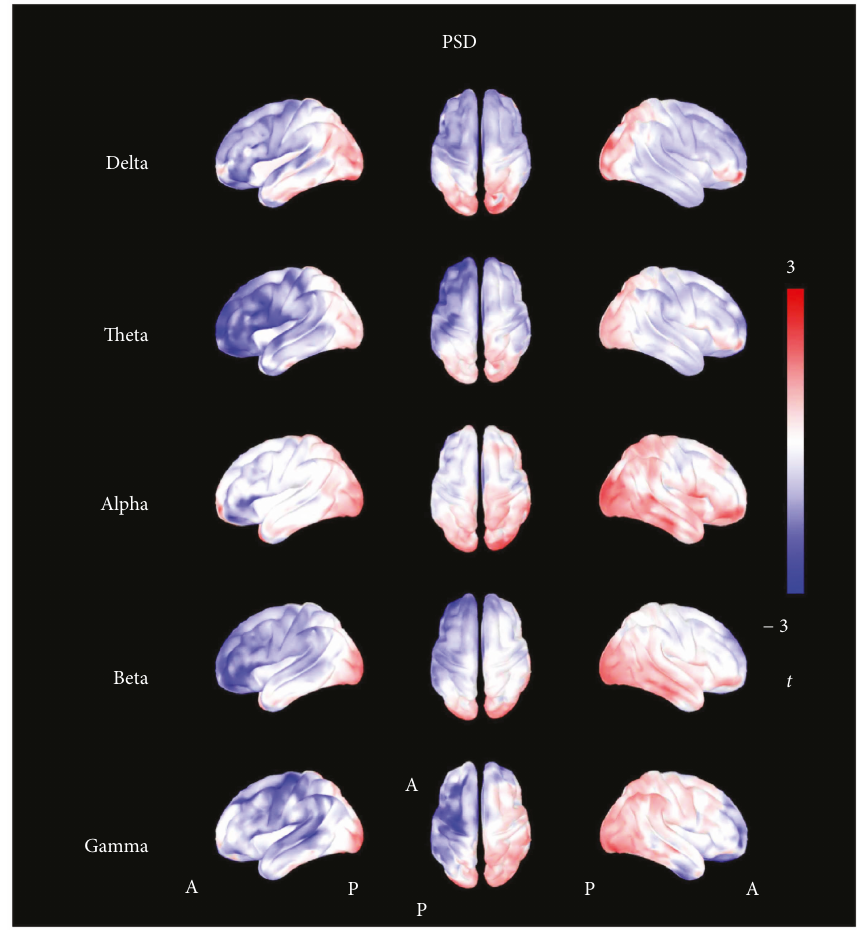
Figure 3: t -maps of resting-state activity (PSD). The fi gure shows the topographic distribution of t -values calculated for the power spectrum density (PSD). Shades of red colors indicate positive values, shades of blue colors indicate negative values, and shades of white indicate values toward zero. The t -maps show a global reduction of PSD in all frequency bands, mostly localized in the left frontal